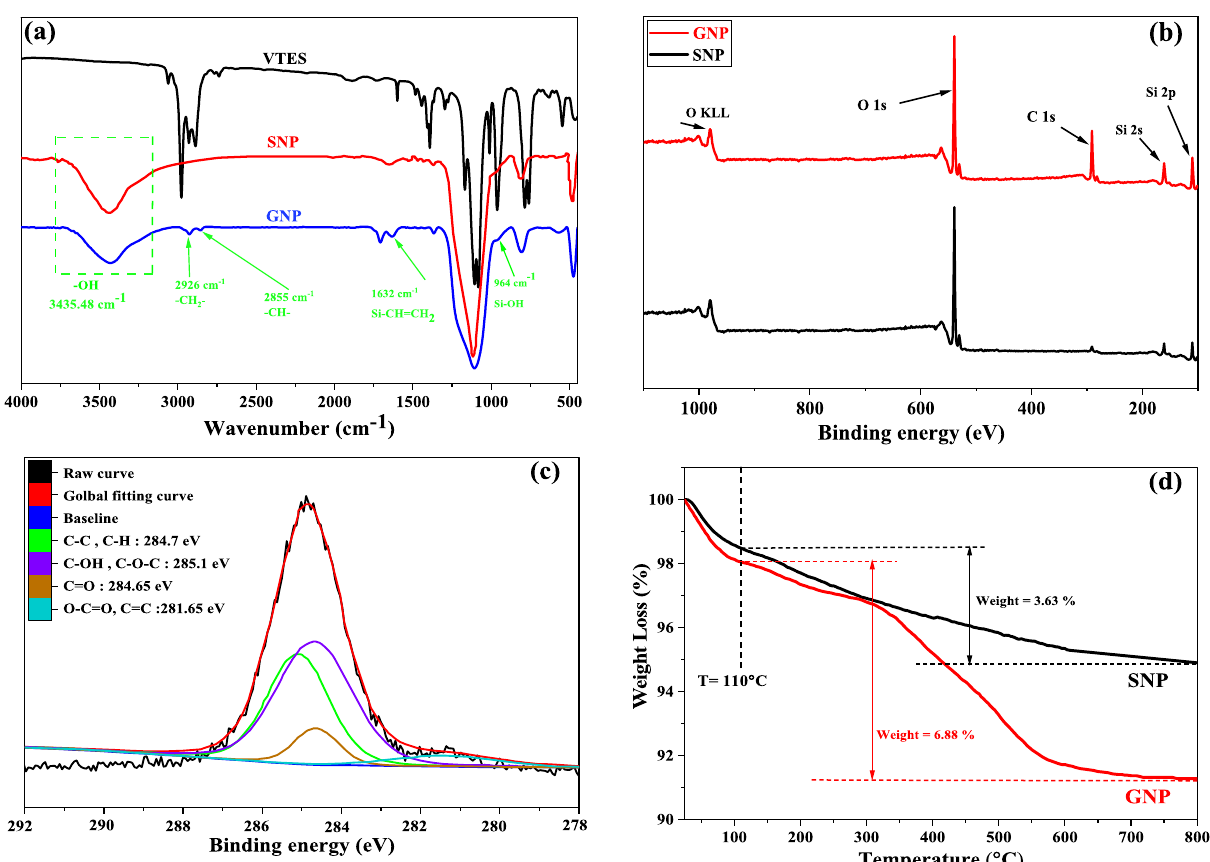
Figure 2. Surface modification of silica nanoparticles with VTES: ( a ) FT-IR curves, ( b ) wide-scan spectra of pure silica and modified silica (XPS), ( c ) C 1S spectrum of modified silica and ( d ) TGA